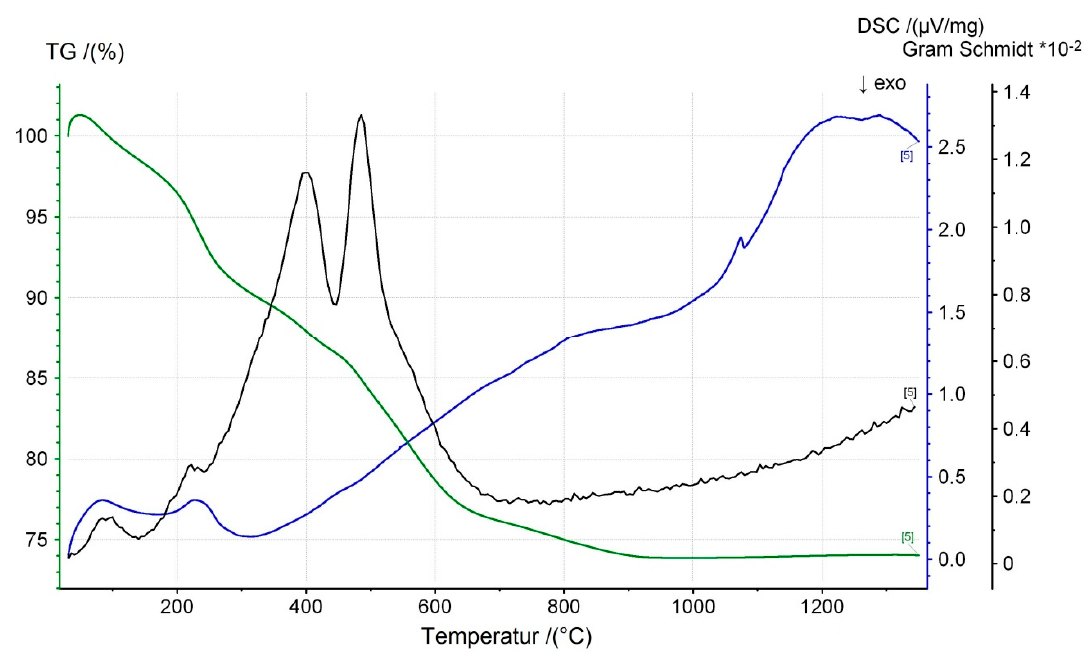
Figure 6. Simultaneous thermal analyses (STA) of the abrasion product of sample A (green line: thermogravimetry (TG), blue line: differential scanning calorimetry (DSC), black line: Gram Schmidt curve).